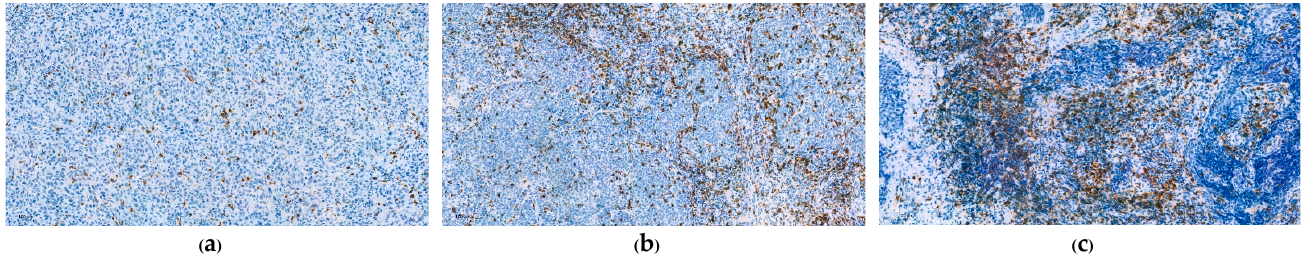
Figure 2 . Immunohistochemical staining for CD8 ( 100× ). ( a ) CD8 > 1 % but < 5 % ; ( b ) CD8 > 5 % but <10 % ; Figure 1 . Immunohistochemistry of p16 - positive OPSCC ( 100× ). ( c ) CD8 > 10 %.